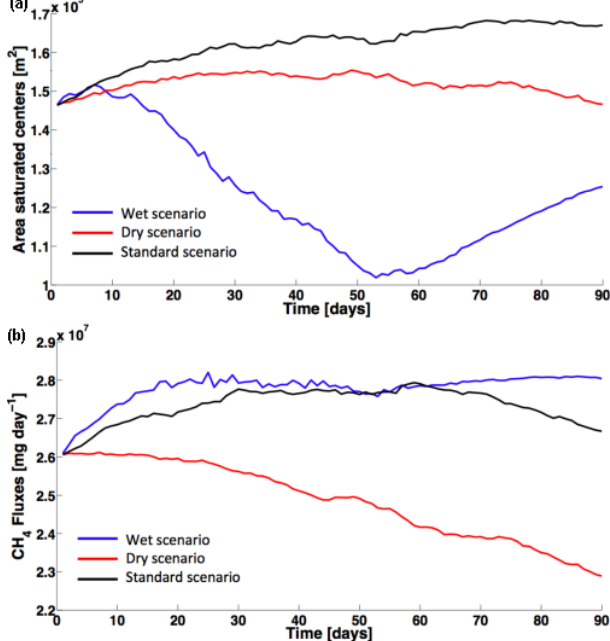
Fig. 5. Ensemble averages of 30 model simulations. The graph in panel (a) displays water table variations over time. Assuming no runoff, and storage term equal to zero, water level should corre- spond to the blue curve (cumulative precipitation minus cumulative evapotranspiration). Field datasets clearly show a drop in water ta- ble at the end of the season, due to lateral runoff, when water table lies above the thaw depth. Panel (b) shows water table dynamics in the three simulated scenarios: wet (blue line), dry (red line), and standard (black line). Shaded areas represent the variance of the en- semble simulations, which increases with the increase of the amount of water input.